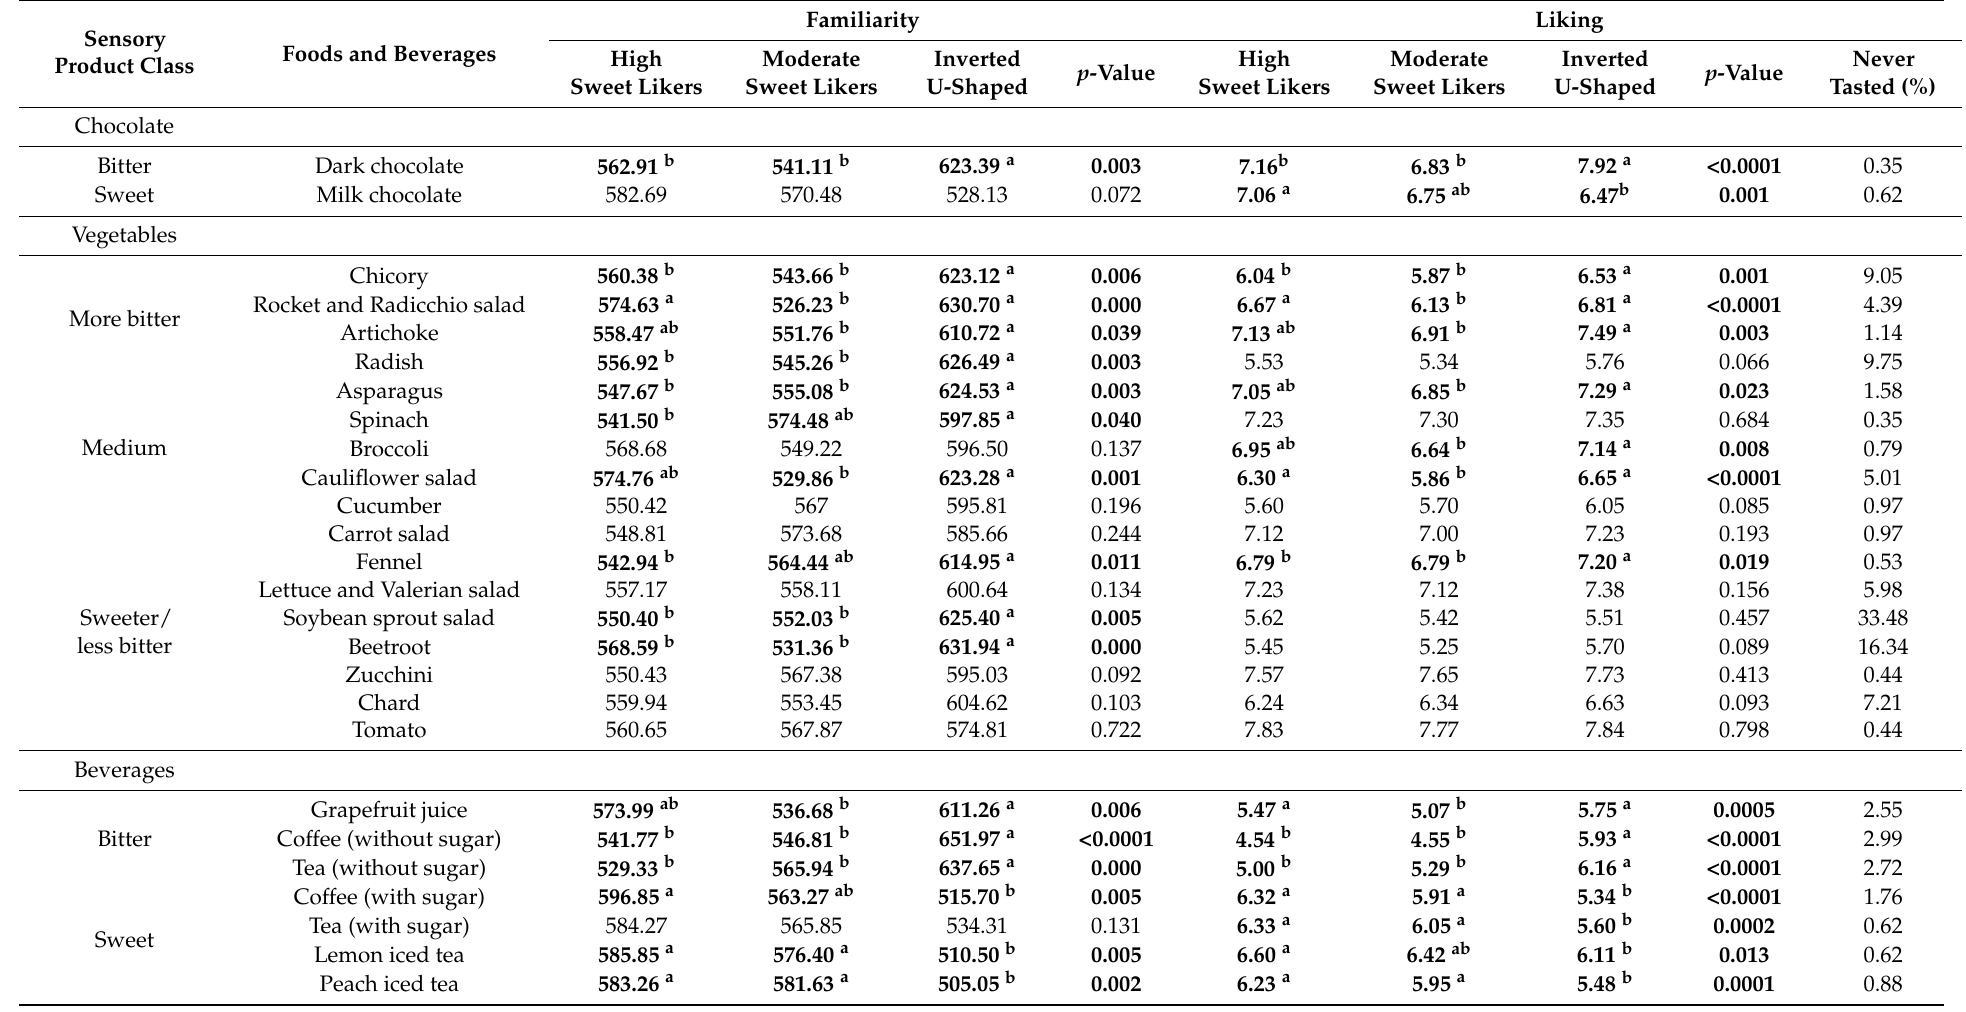
Table 3. Familiarity and liking of phenol-rich foods differing in sensory properties (products and product class) by